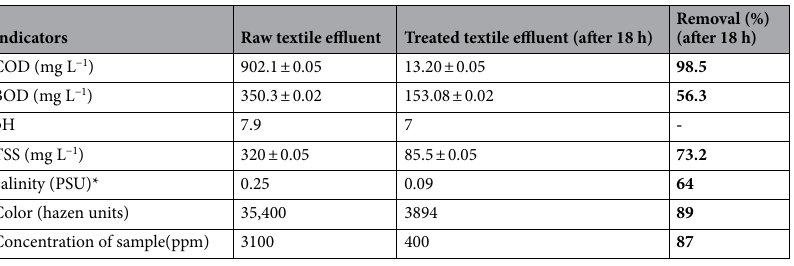
Table 1. Conventional indicators in raw and treated textile effluent. *PSU- Practical Salinity